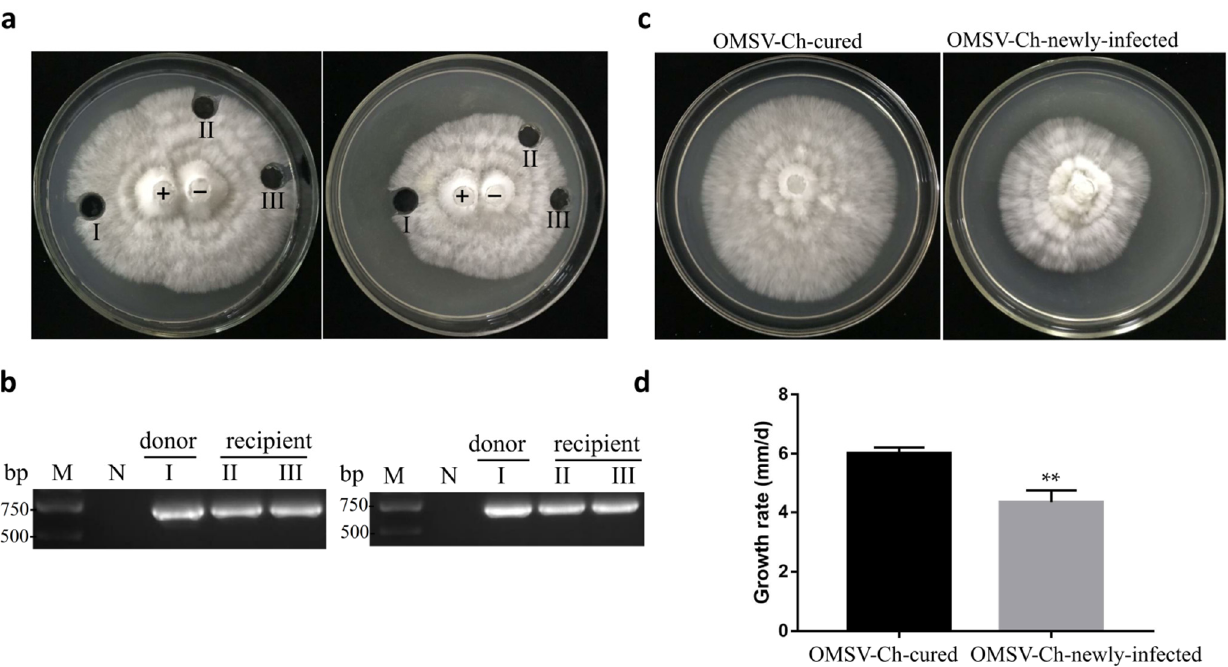
Figure 6. Pairwise co-cultivation of OMSV-Ch-infected (+) and OMSV-Ch-cured ( − ) strains of P. ostreatus. ( a ) After incubation for 5 days at 25 ◦ C, one inoculum from the donor side (I) and two inocula from the recipient (II and III) were sub-cultivated for 5 days. ( b ) RT-PCR detection for the presence of OMSV. Negative controls of pairing tests were OMSV-Ch-cured strains. M, GL DNA Marker2000. ( c ) Colony morphology of the OMSV-Ch-cured strain compared to the newly infected OMSV-Ch strain after 5 days of incubation at 25 ◦ C. ( d ) Growth rate of OMSV-Ch-cured and newly infected OMSV-Ch strains of P. ostreatus. ** p < 0.01 highlight significant growth differences by independent sample t -test.